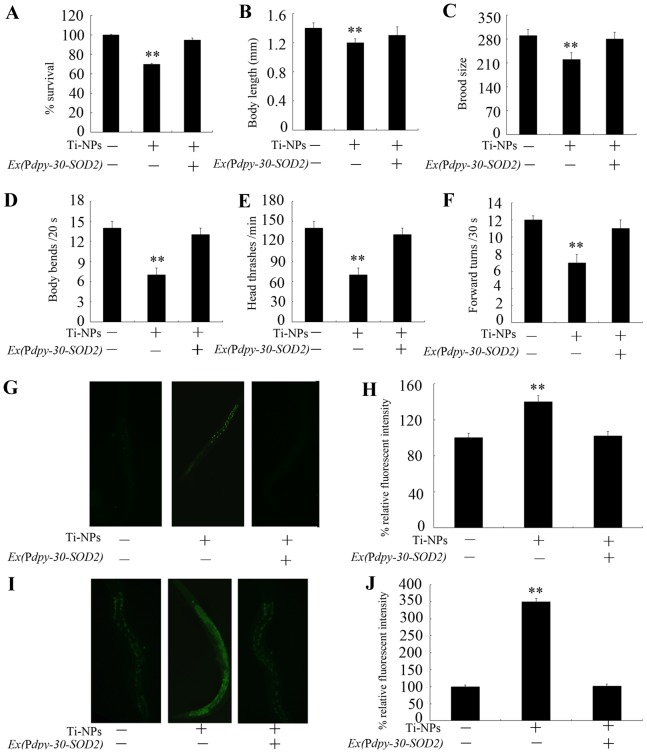
Effects of ectopically expression of human SOD2 gene on the toxicity formation in animals exposed to 4 nm TiO2-NPs at the concentration of 10 µg/L.(A) Effects of ectopically expression of human SOD2 gene on the survival of animals exposed to 4 nm TiO2-NPs at the concentration of 10 µg/L. (B) Effects of ectopically expression of human SOD2 gene on the growth of animals exposed to 4 nm TiO2-NPs at the concentration of 10 µg/L. (C) Effects of ectopically expression of human SOD2 gene on the reproduction of animals exposed to 4 nm TiO2-NPs at the concentration of 10 µg/L. (D–F) Effects of ectopically expression of human SOD2 gene on the locomotion behavior of animals exposed to 4 nm TiO2-NPs at the concentration of 10 µg/L. (G–H) Effects of ectopically expression of human SOD2 gene on the intestinal autofluorescences of animals exposed to 4 nm TiO2-NPs at the concentration of 10 µg/L. (I–J) Effects of ectopically expression of human SOD2 gene on the ROS production of animals exposed to 4 nm TiO2-NPs at the concentration of 10 µg/L. Exposure of Ti-NPs was performed from L1-larvae, and the endpoints were examined when nematodes developed into the adults. Ti-NPs, TiO2-NPs. The Bars represent mean±S.E.M. **p<0.01.